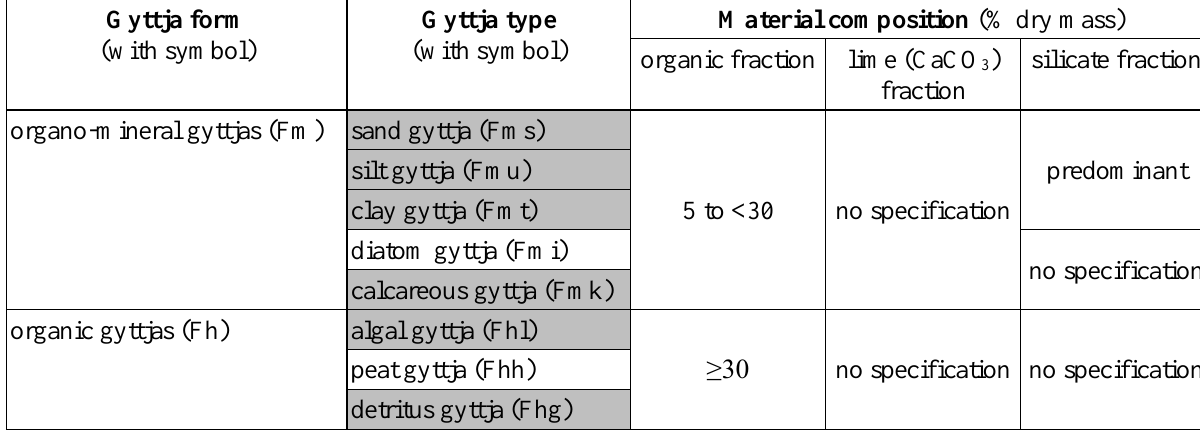
Table A1.3. Gyttja classification of the latest German soil mapping manual KA5 (Ad-hoc-AG Boden 2005), translated from German, compared to the gyttja types included in our key and portraits